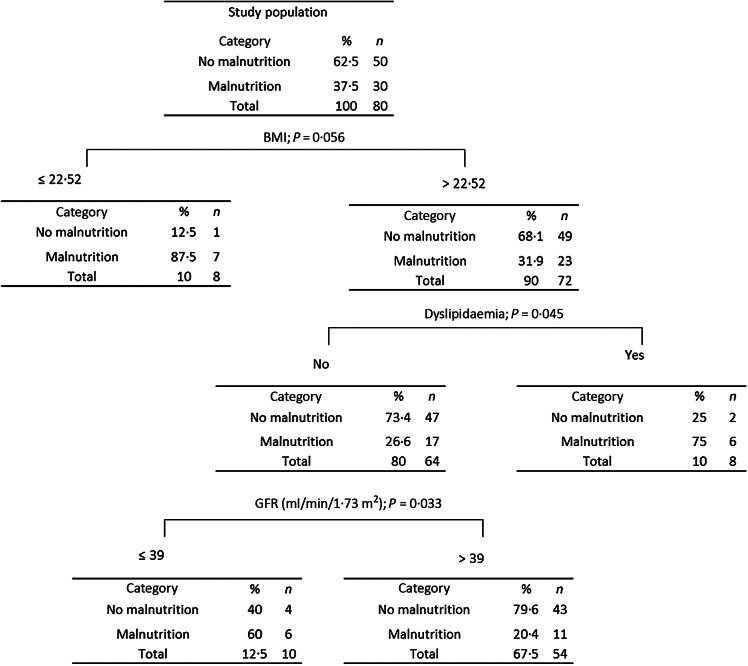
Classification and Regression Tree (CART) according to BMI, dyslipidaemia and glomerular filtration rate (GFR).